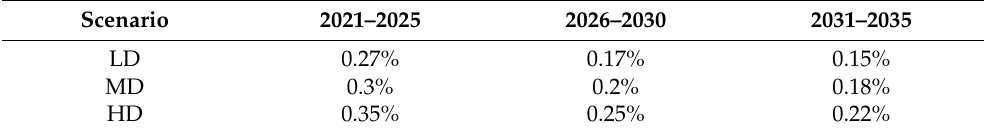
Table 1. Average annual natural population growth rate of Shandong Province from 2020 to 2035.